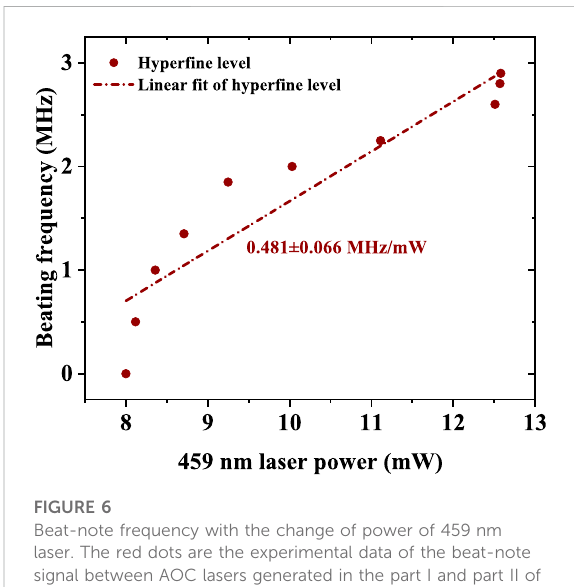
FIGURE 7 Beat-note frequency with the change of an external magnetic fi eld. The black square dots are the experimental data of beat-notesignalbetweenZeemansublevelsgeneratedinthepartI of Figure 1A. The data are fi tted linearly with a slope of − 395.8 ± 46.91 kHz/G (black dotted